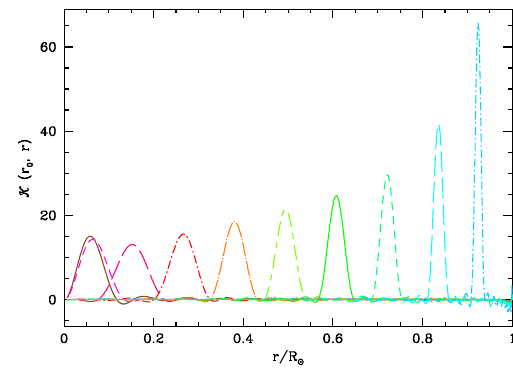
Fig. 13 A sample of averaging kernels for sound-speed inversions obtained with the SOLA method. The averaging kernels were obtained for inversions of the frequency differences between Model S and the solar dataset BiSON-13 of Basu et al. (2009). The results are for the inversions reported in that